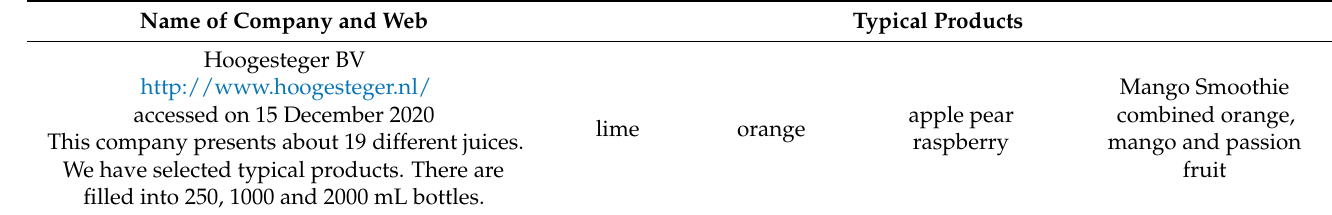
Table A8. High pressure treated products by the company Hoogesteger